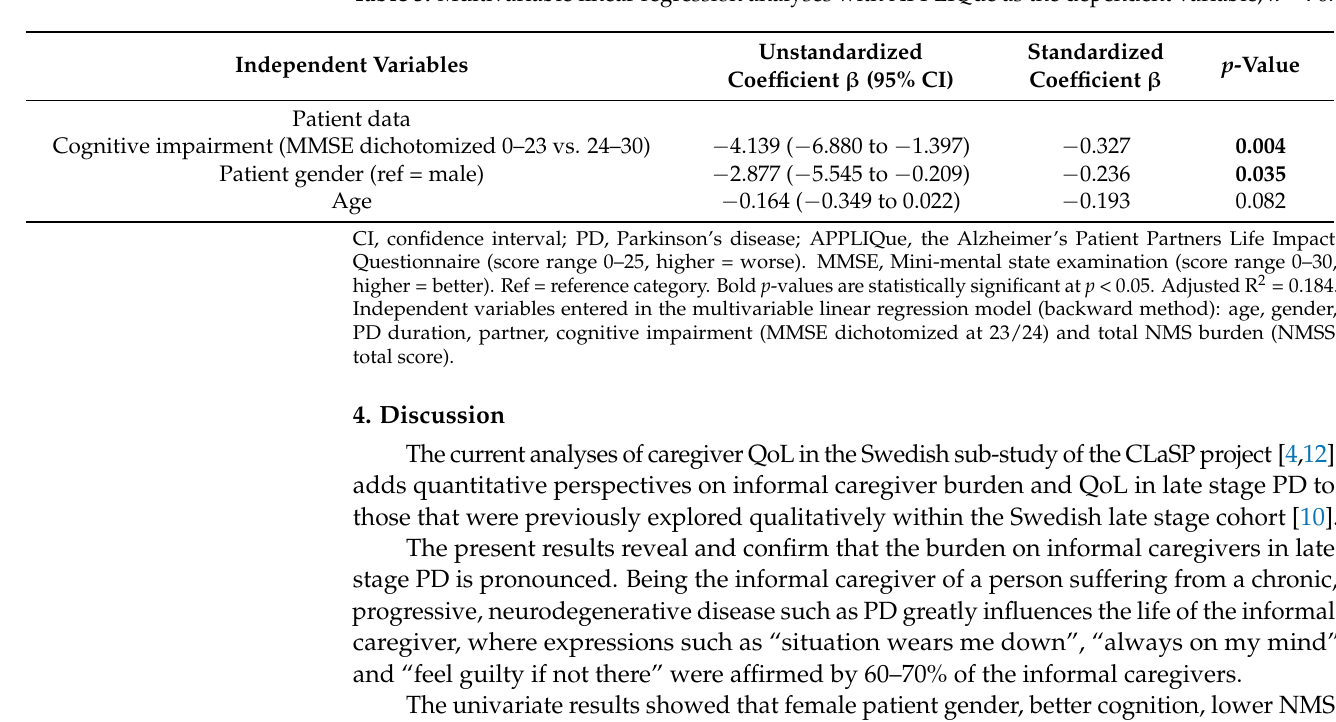
Table 3. Multivariable linear regression analyses with APPLIQue as the dependent variable, n =